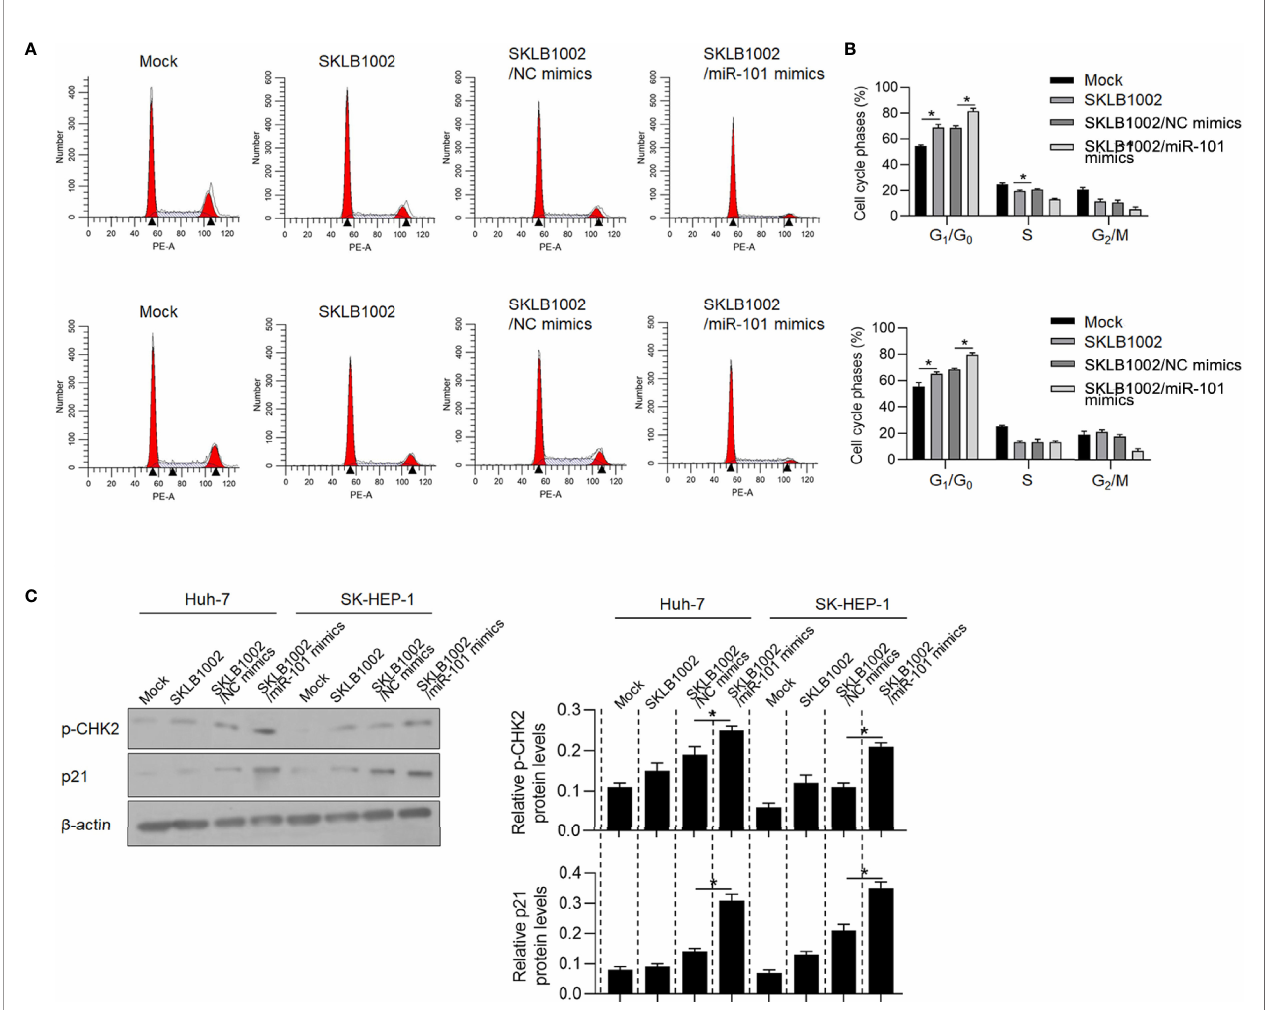
FIGURE 8 | CCDC88A regulates cell proliferation partially via regulating VEGFA. (A, B) After the addition of SKLB1002, a VEGFR2 inhibitor, transfected miR-101 mimics further blocked the cell cycle at G 1 /G 0 . *P < 0.05, vs. mock group; *P < 0.05, vs. SKLB1002/NC mimics group. (C) western blot was performed to detect p- CHK2 and p21 protein levels. *P < 0.05, vs. SKLB1002/NC mimics